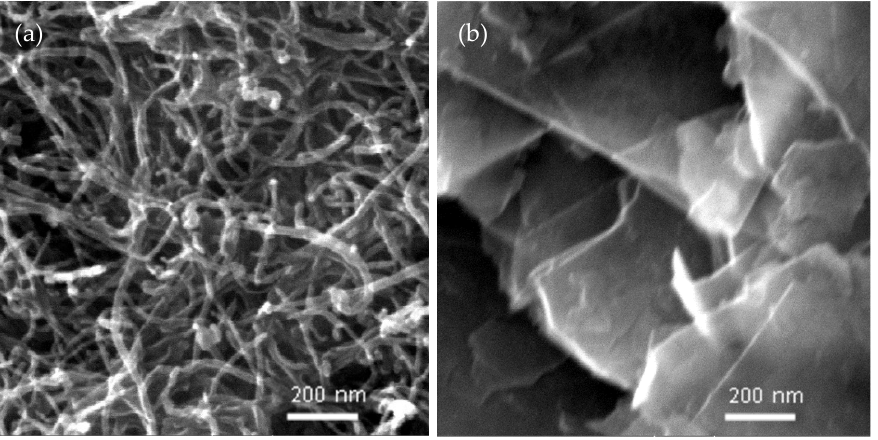
Figure 1. FESEM micrographs of pure CNTs ( a ) and GNPs ( b ).